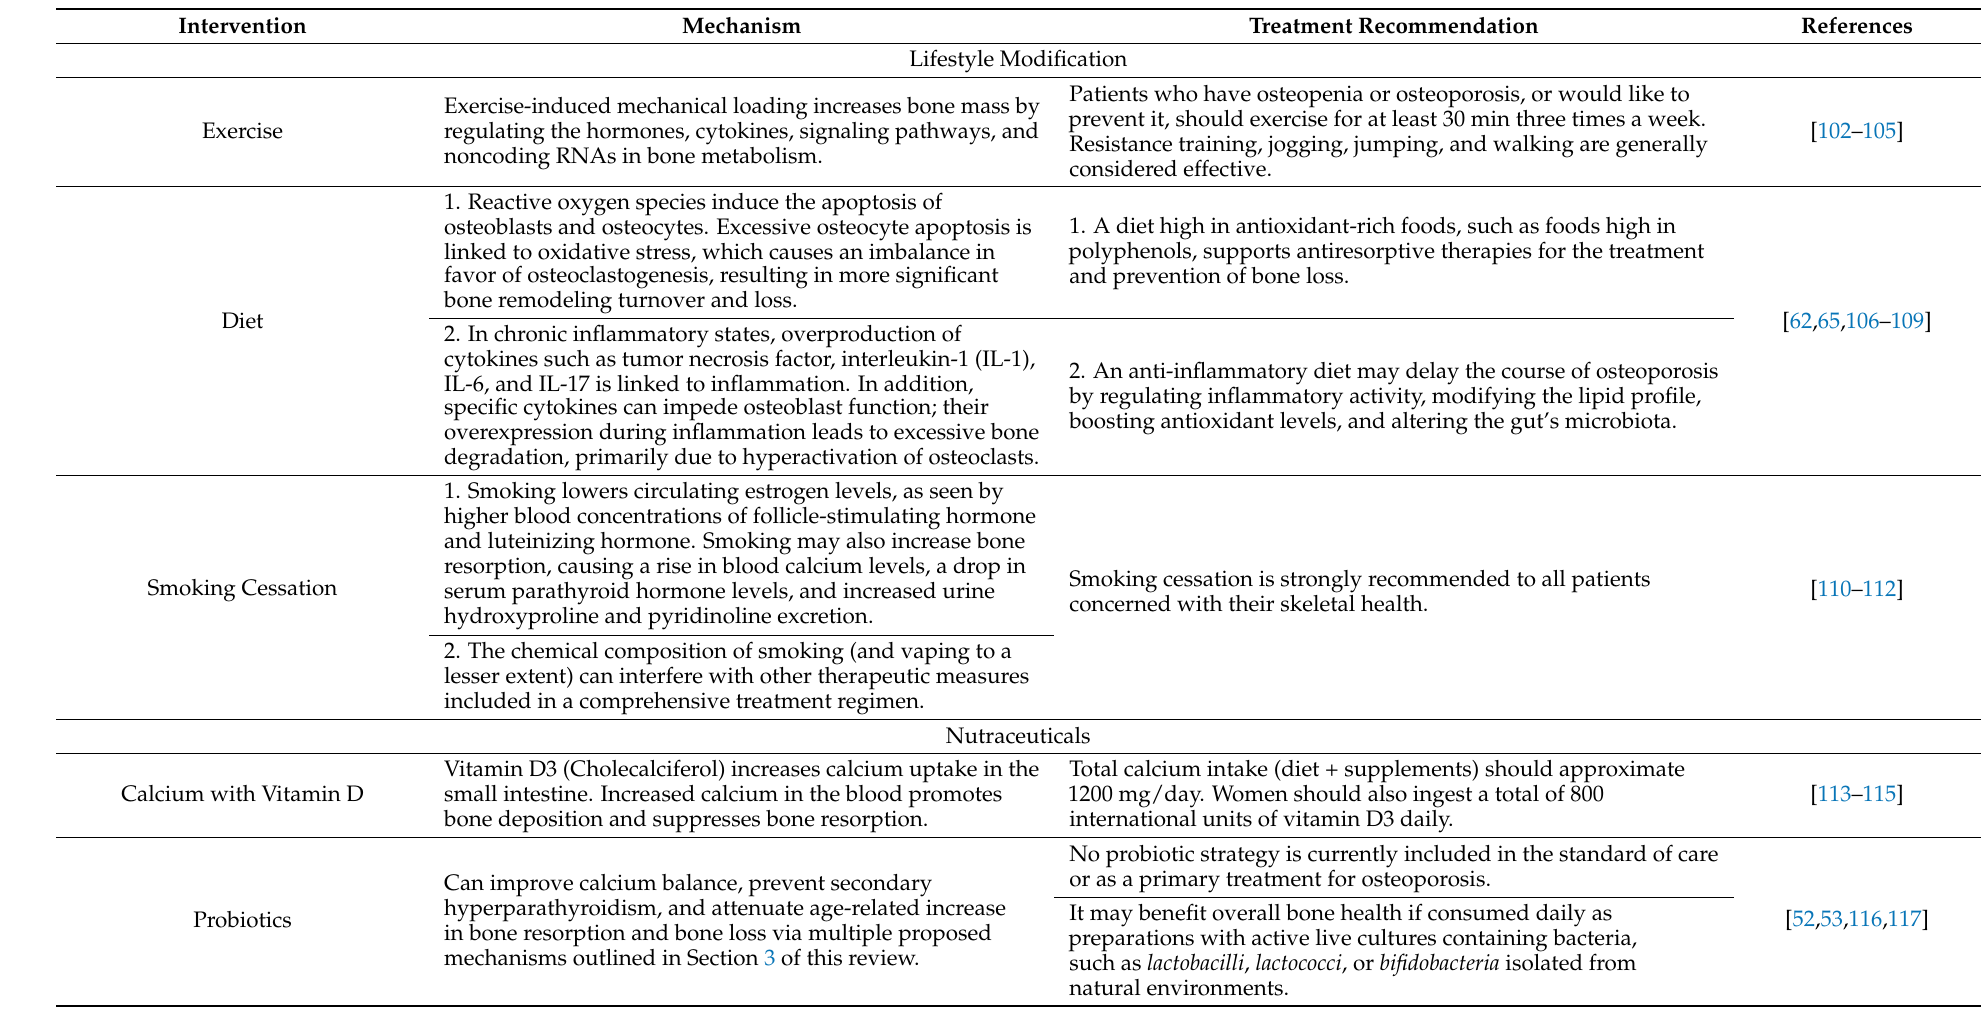
Table 1. Mechanisms of action and treatment recommendations for